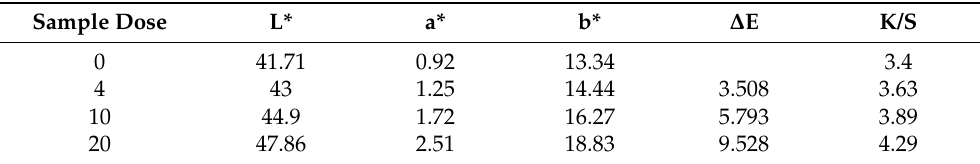
Table 2. Mean deviation of the CIELab coordinates L*, a*, b*, the ∆ E and K/S values for unirradiated and X-irradiated PVA/NBT films from 4 to 20 mGy.